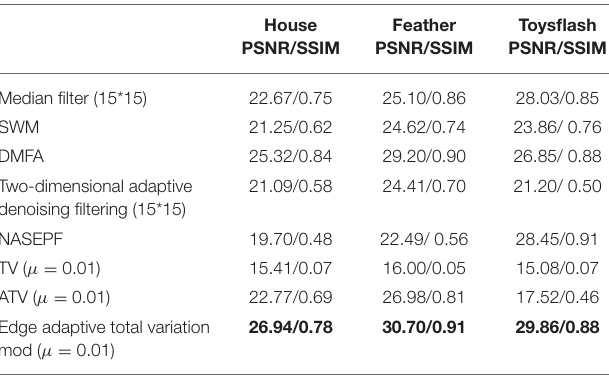
TABLE 2 | PSNR and SSIM scoring results of different images with 20% salt and pepper noise